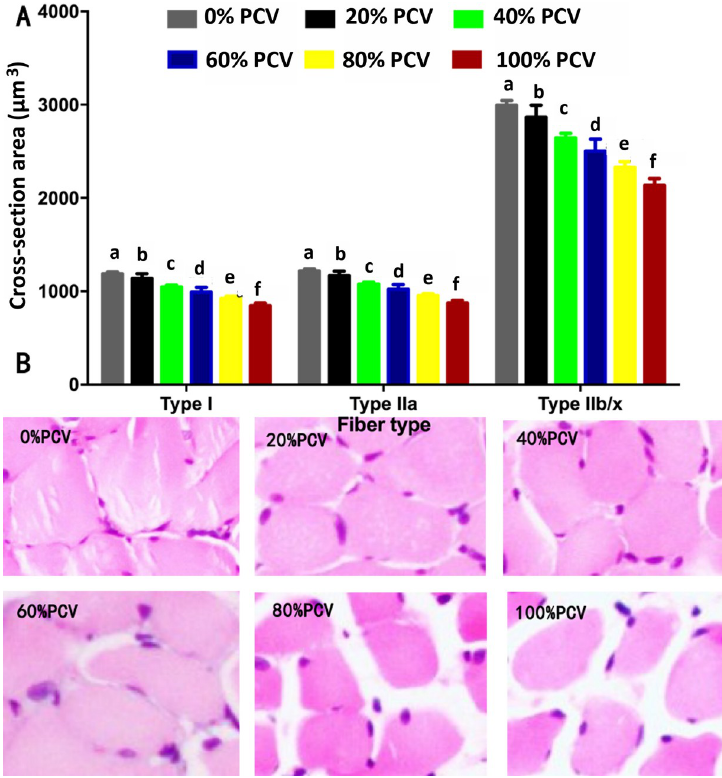
Fig 5. Cross-section areas of diaphragmatic fibers after 24-h controlled mechanical ventilation at different intensities. A, bar chart. B, representative photos under the light microscope ( × 20). A different letter indicates a significant difference (P <